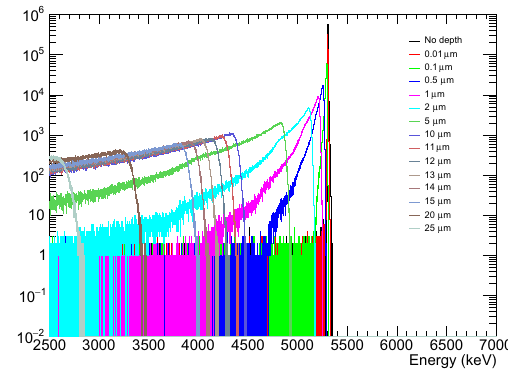
Fig. 11 Simulated energy distributions of 210 Pb events generated at the Vikuiti surface depths of 0, 0.1, 0.5, 1, 2, 5, 10, 15, 20, and 25 µ m